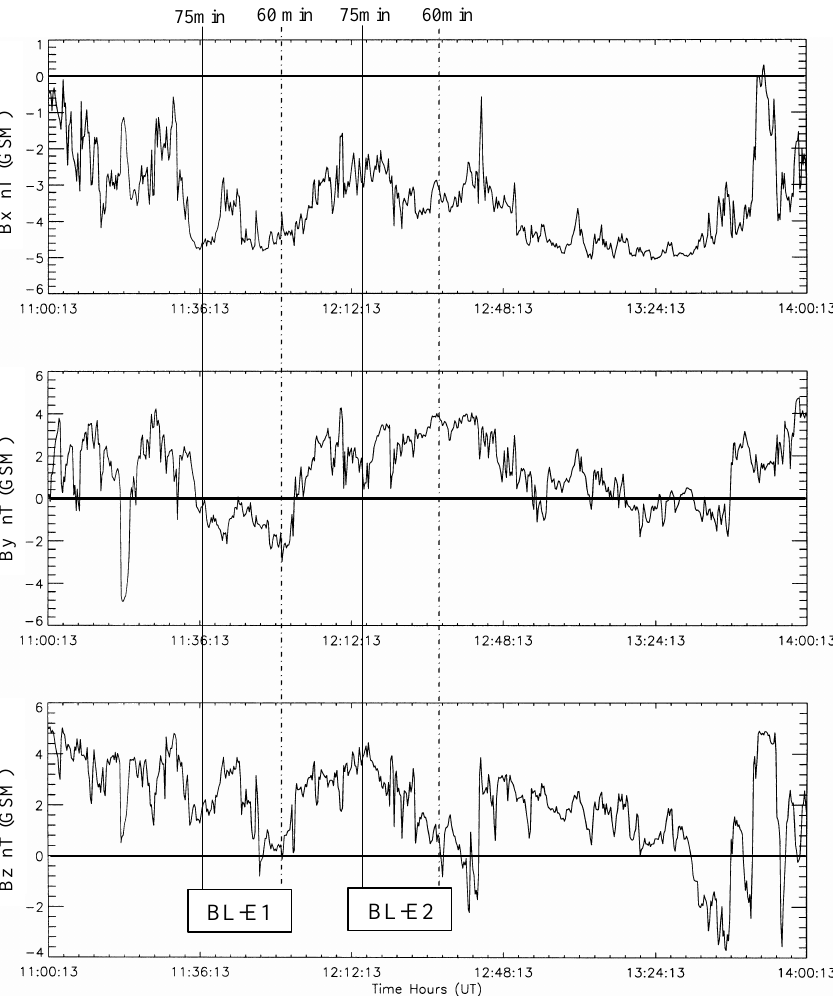
Fig. 2. The components B X , B Y , and B Z of the interplanetary magnetic field in GSM coordinates observed by ACE near the L1 point. The full and dot- dashed vertical lines mark the IMF con- ditions for two boundary layer encoun- ters by Cluster assuming a time shift of 75 and